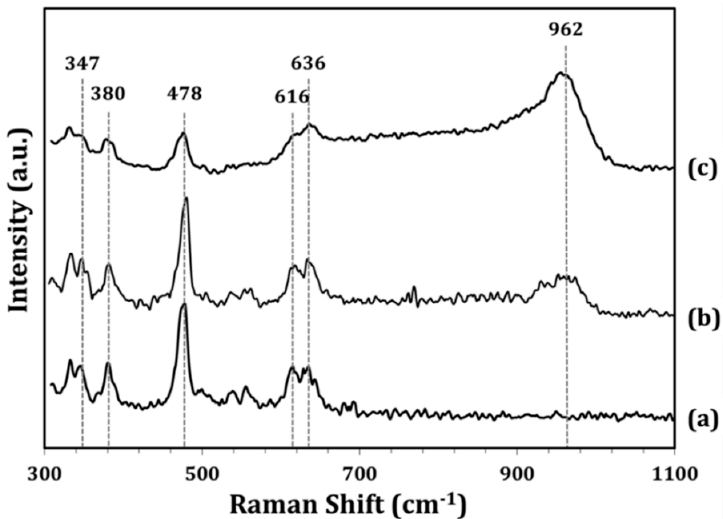
Figure 3. Raman spectra of (a) ZrO 2 , (b) impW-Zr (10-wt% WO x ), and (c) 5W-Zr samples under ambient conditions.